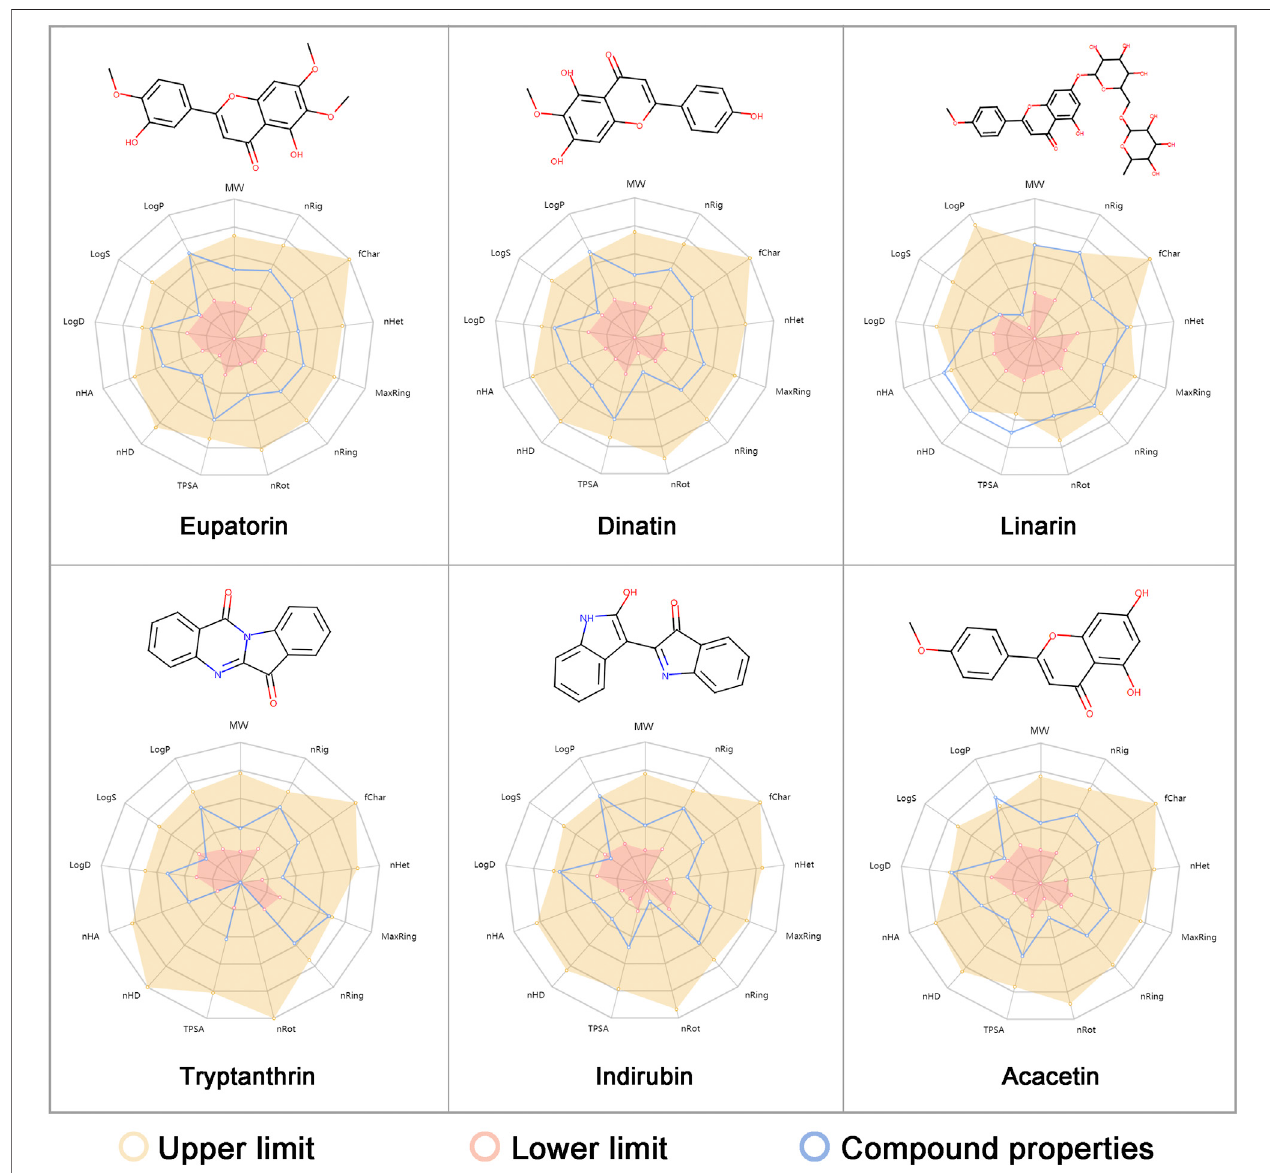
FIGURE 5 | Compound structures and physicochemical properties of the six predicted anti-in fl uenza A virus (IAV) ingredients (eupatorine, dinatin, linarin, tryptanthrin, indirubin, and acacetin) selected for in vitro evaluation. Theradar plot exhibitsthe physicochemical propertiesof each compound(in blue ) and thereference optimal scope (in yellow and red ). The optimal range of the chemical and physicochemical properties is provided by ADMETlab 2.0 (Xiong et al., 2021). Detailed explanations of the endpoints can be found in Supplementary Table S5 .